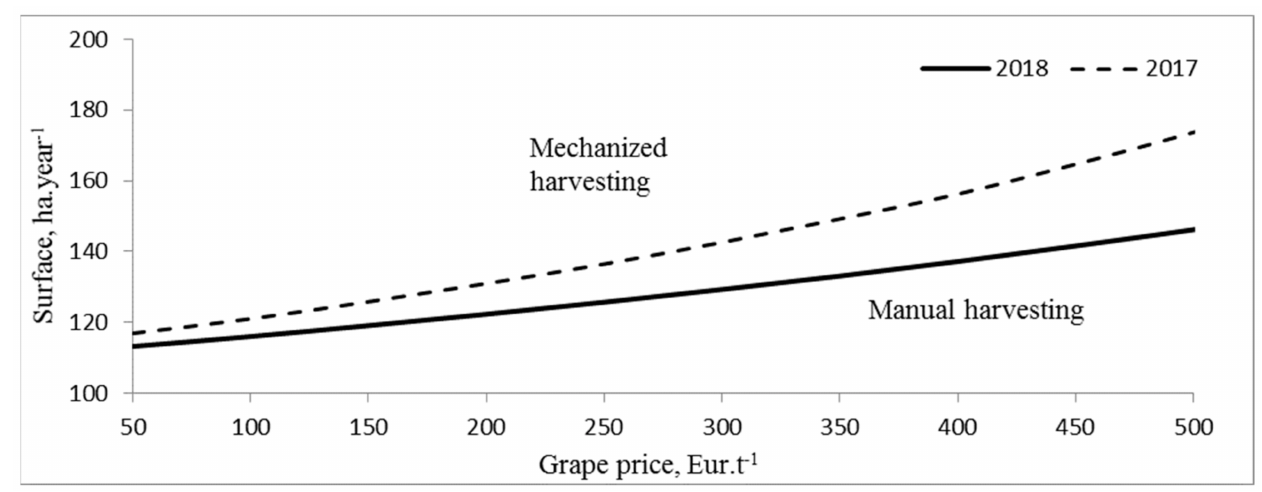
Figure 5. Break-even areas under different combinations of harvested area and grape price.